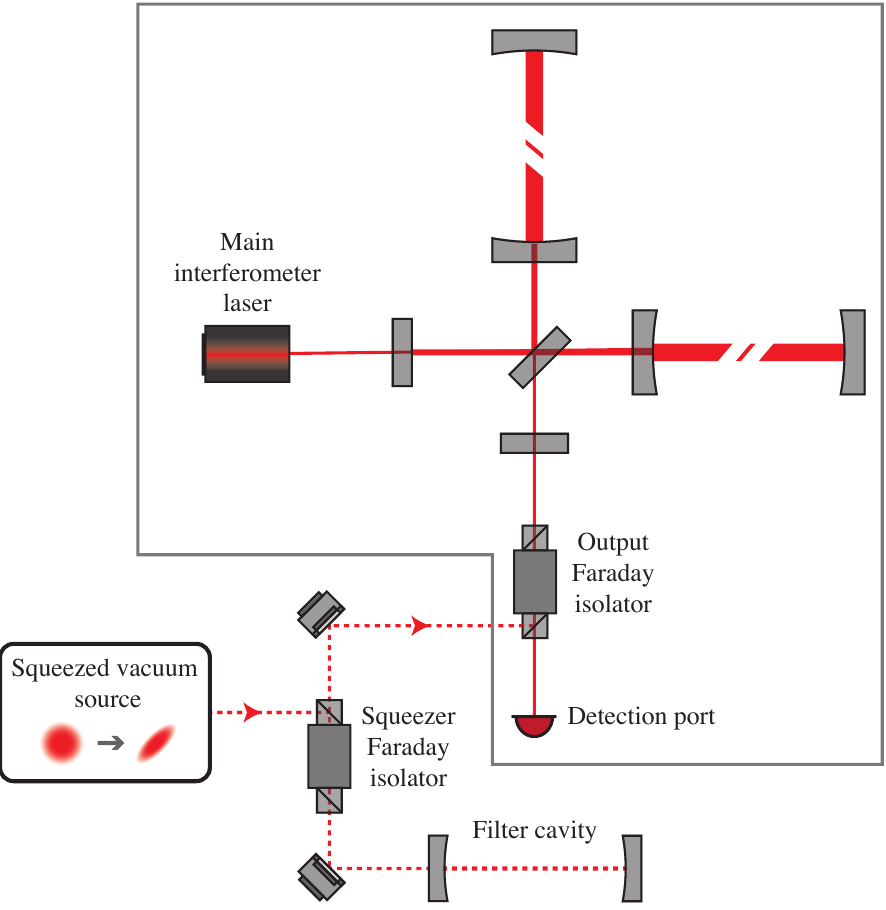
Figure 3. Simplified optical layout of a dual-recycled Fabry–Perot Michelson interferometer (grey box), with frequency-dependent squeezing injected at the output port, as is planned the aLIGO and AdVirgo detectors in Observing Run 4. The squeezed vacuum source generates frequency- independent squeezed light. The squeezed beam (dashed red line) is reflected off the filter cavity, passes back through one or more squeezer Faraday isolators, and is injected into the main interferom- eter through the output Faraday